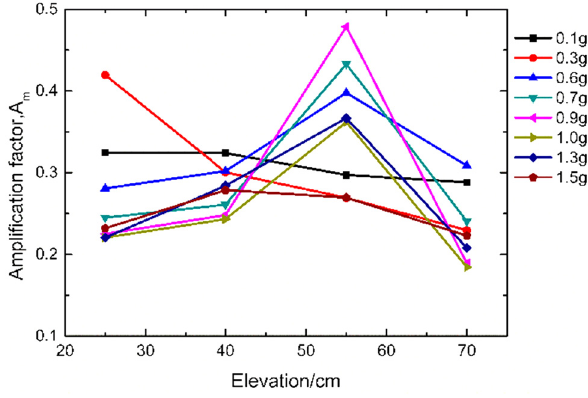
Figure 13: Ampli fi cation factor A m at JY1, JY2, JY3, and JY4 against variable elevation.